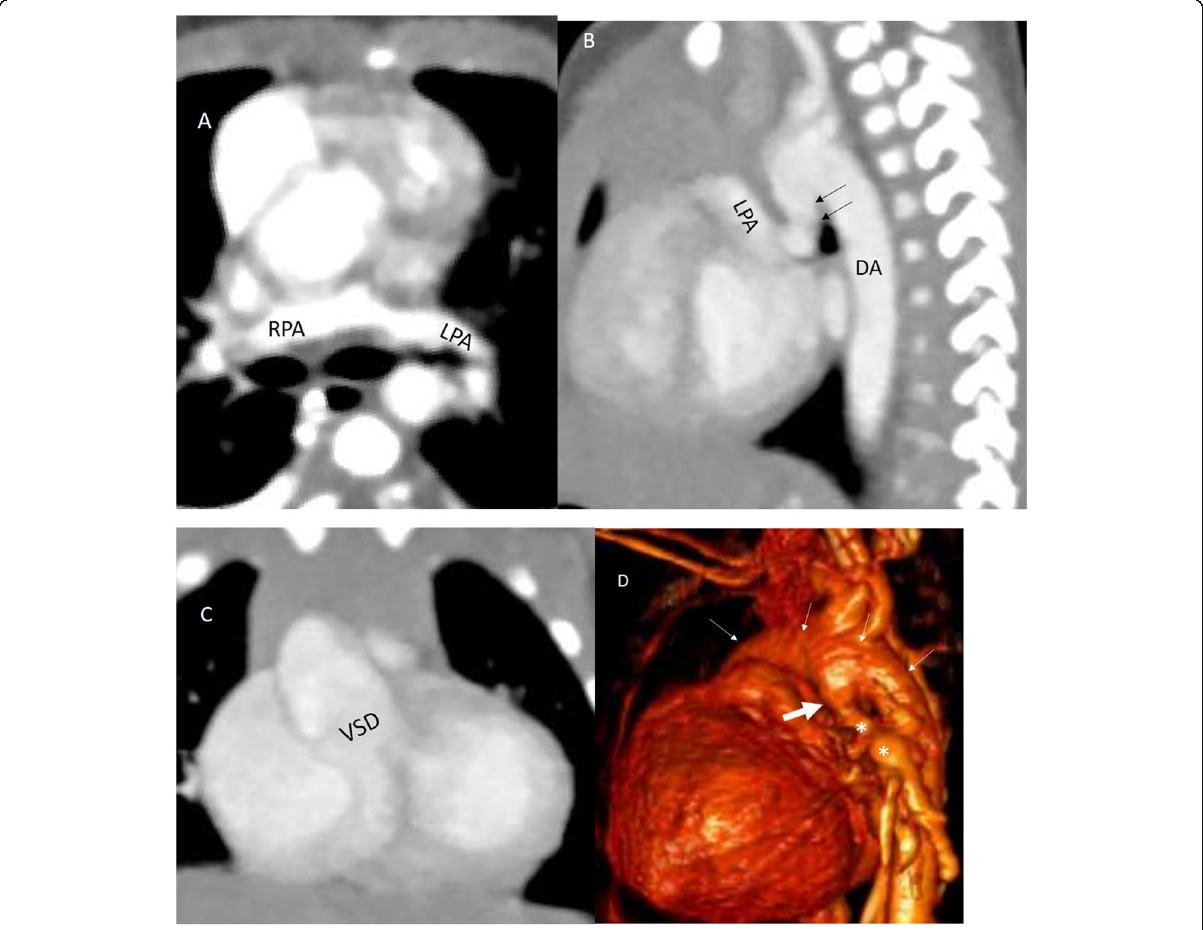
Fig. 1 A 3-week-old baby with pulmonary atresia and low O2 saturation. a Axial CT shows atretic MPA, small RPA, and LPA. b Sagittal 2D MIP: refilling of the LPA via a vertical PDA (arrows). c Coronal 2D MIP shows a large VSD. d 3DVR: vertical PDA (black arrow) arising from aorta (small arrows) to supply the LPA (*)